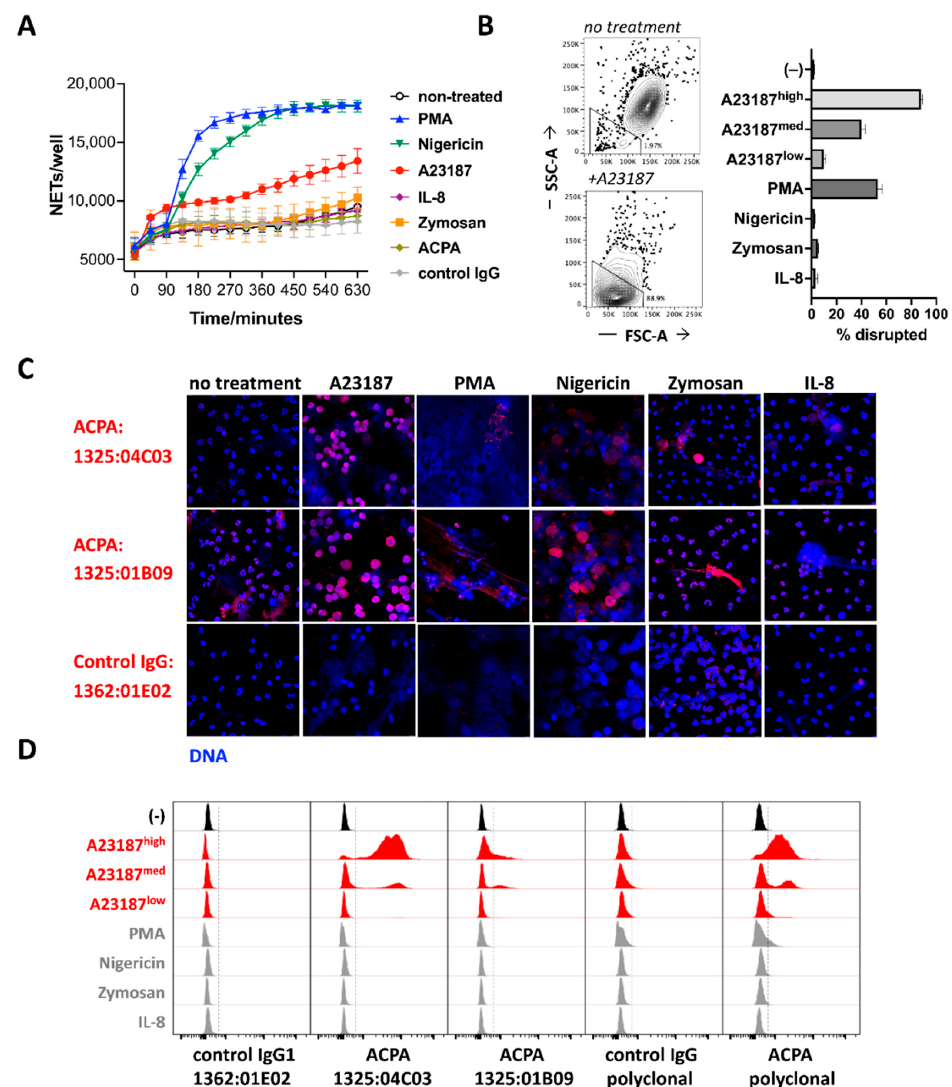
Figure 1. ACPA binding to neutrophil-derived antigen is associated with NETosis. Neutrophils were exposed to different stimuli and NETosis was quantified using IncuCyte ( A ). Granularity and cell size were analyzed by flow cytometry ( B ). Neutrophils were activated by using different stimuli for 3 h, and binding of ACPA or control antibodies was studied by confocal microscopy. DNA was stained by DAPI ( C ). ACPA binding was also analyzed by flow cytometry under the same conditions, using monoclonal and polyclonal ACPA and control antibody staining on fixed and permeabilized samples. Dashed lines, placed with the help of the control antibody-stained samples, represent the cutoff for stained events ( D ). Representative results of three independent experiments are shown. A23187 high , A23187 med and A23187 low concentrations correspond to 25, 5 and 1 µ M,